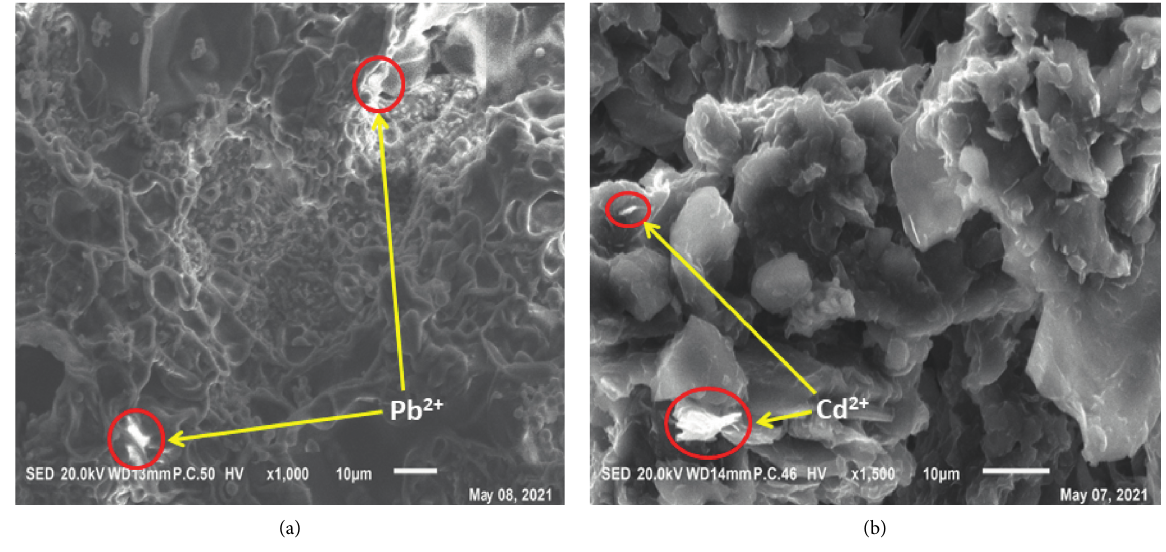
Figure 2: SEM of the CPE-ACC: (a) with Pb and (b) with Cd.